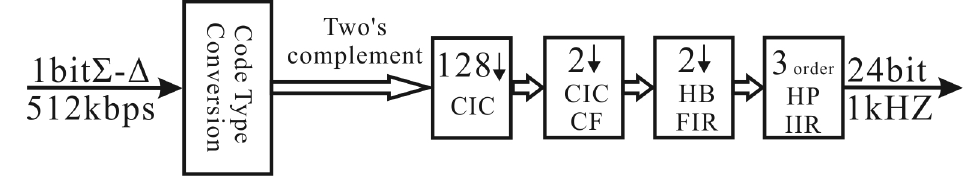
Figure 5. Acquisition of high-definition AD transmission digital filter by the data-acquisition station. HB FIR, half-band FIR filter; CF, com- pensation filter; HP IIR, high-pass IIR